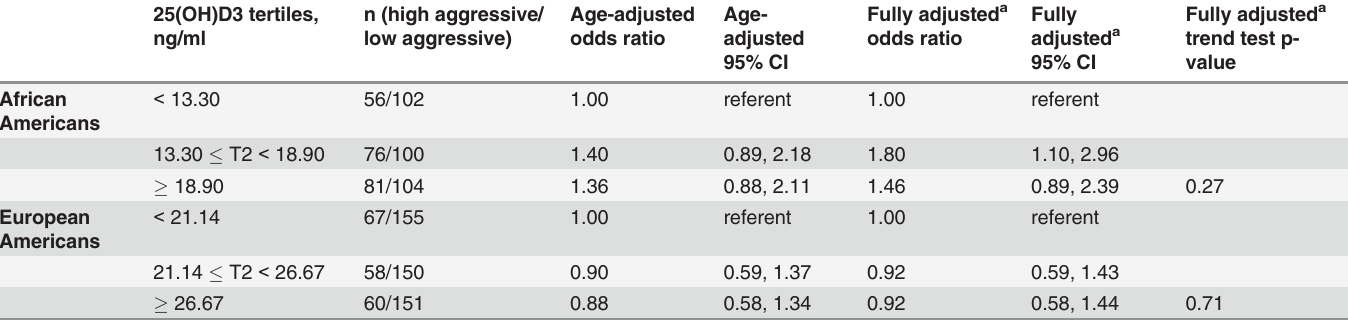
Table 2. Age- and multivariable-adjusted odds ratios and 95% confidence intervals for high aggressive prostate cancer by tertiles of plasma 25 (OH)D3. 25(OH)D3 tertiles,